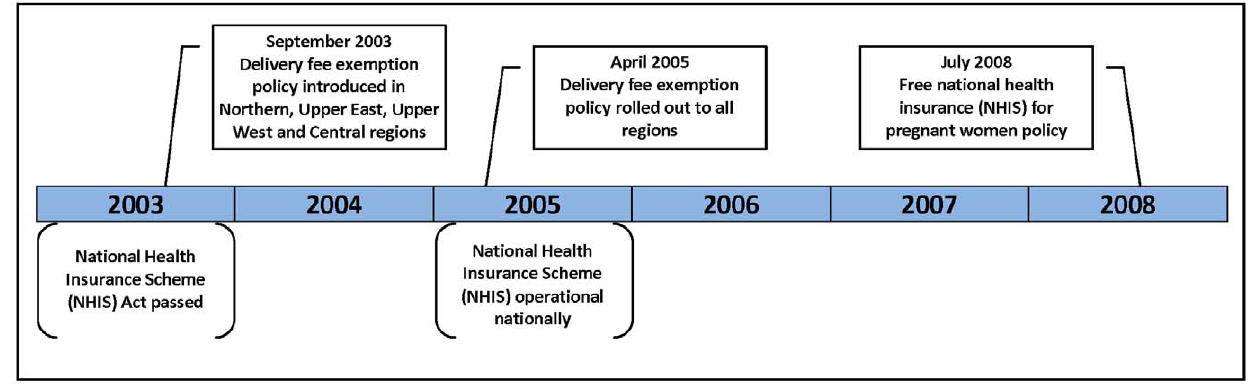
Figure 1. Timing of Ghana’s recent maternal health financing policies. Ghana introduced a delivery fee exemption policy in September 2003, which was rolled out to all regions in April 2005. This policy was followed by free national health insurance for pregnant women in July 2008.